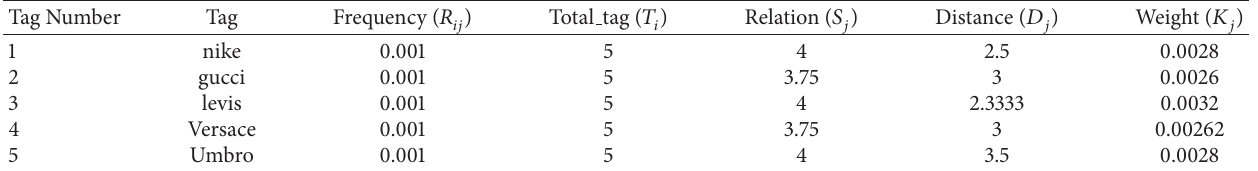
Table 4: Results for invalid tags on the “Apple iPad Mini” theme.